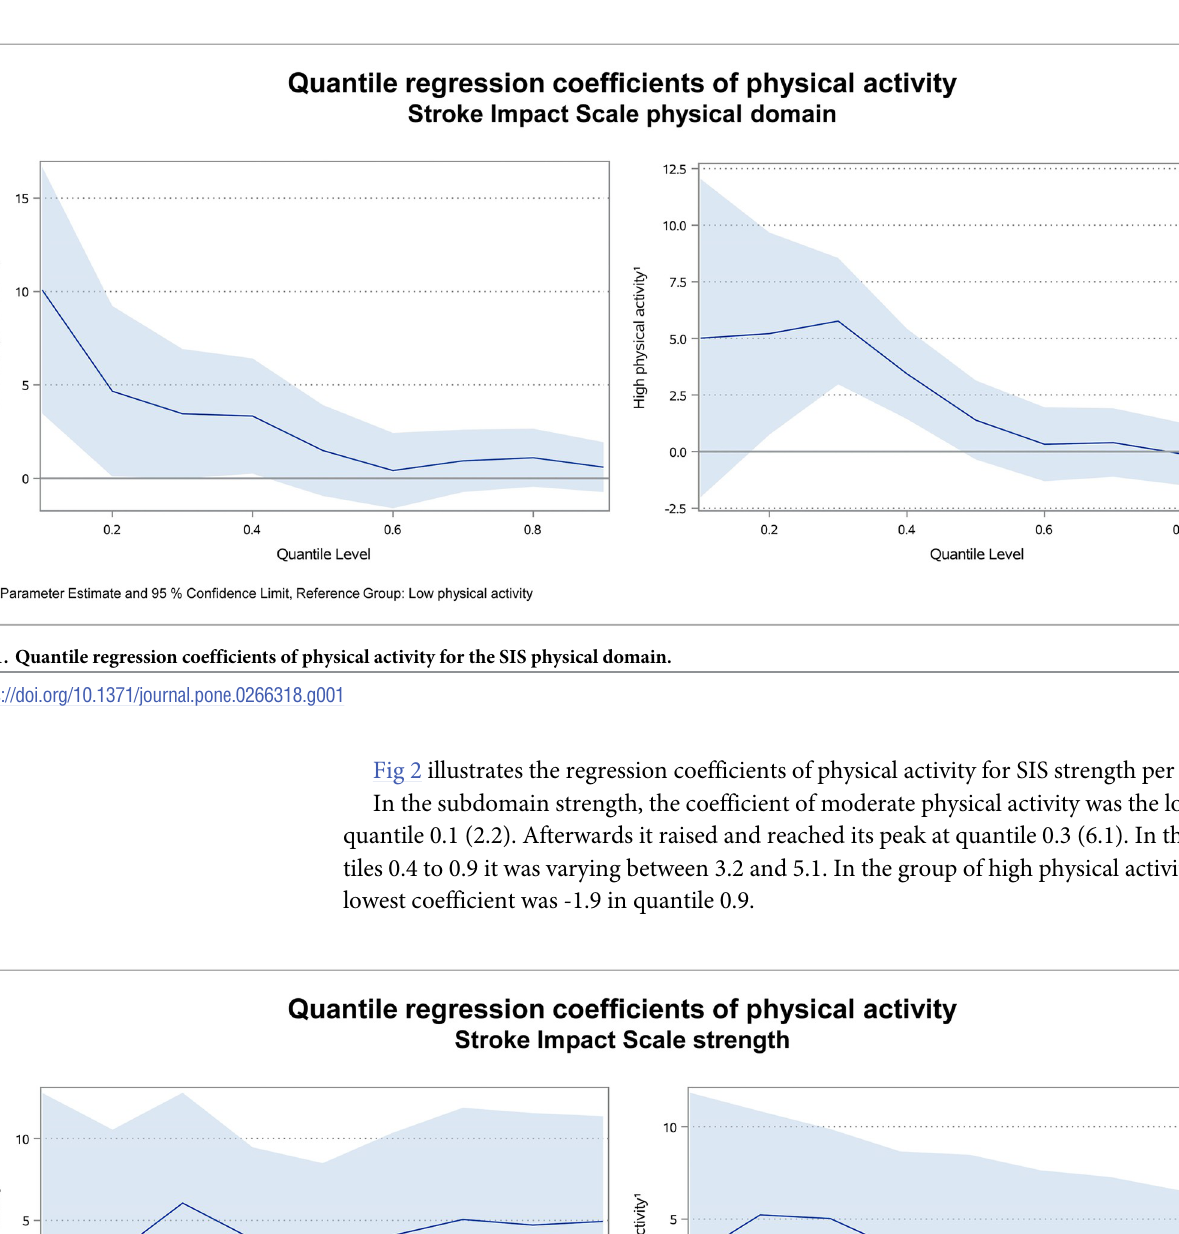
Fig 2. Quantile regression coefficients of physical activity for SIS strength.